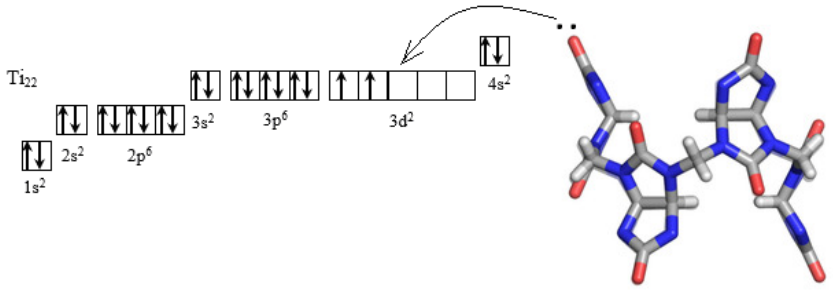
Figure 2. Scheme of donor – acceptor interaction between BU[6] and Ti 22 .